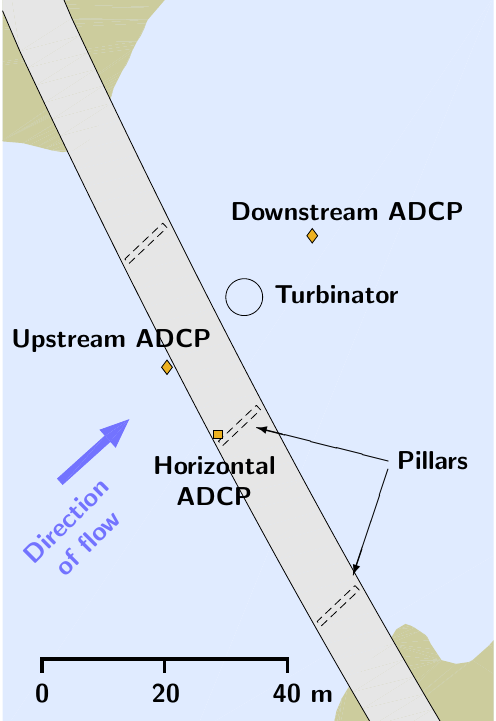
Figure 2. An overview of the test site. The river reach is part of the outlet channel from a hydropower plant. The turbinator is placed immediately downstream of a road bridge. Vertically-oriented ADCPs are placed on the riverbed upstream and downstream of the turbinator. A horizontally-oriented ADCP is mounted on a bridge pillar